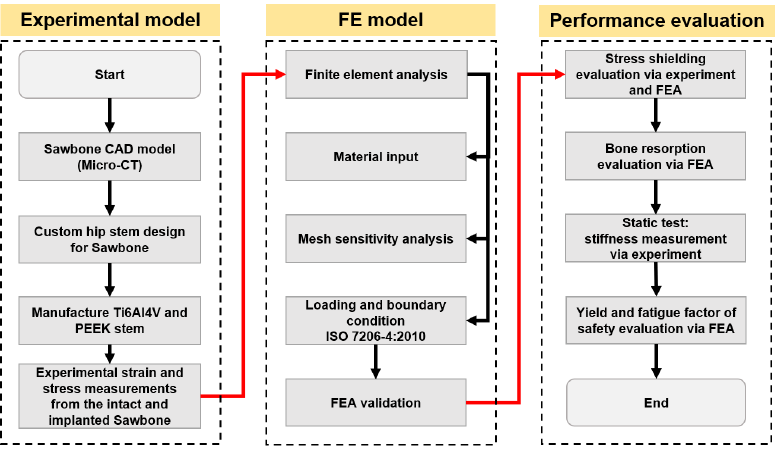
Polymers 2022 , 14 , x FOR PEER REVIEW Figure 1. Flow chart of general strategies used in this study. Figure 1. Flow chart of general strategies used in this study.